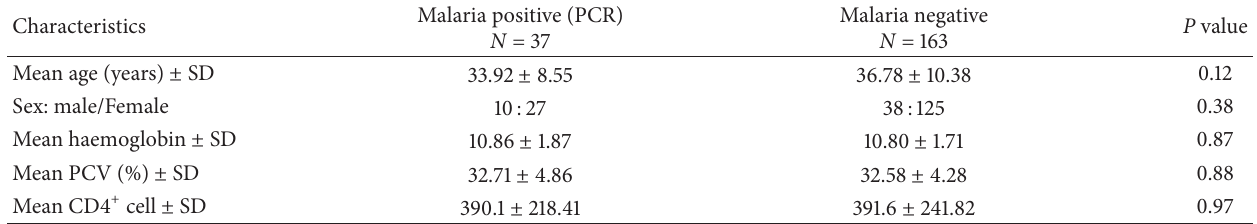
Table 2: Comparison between malaria positive and negative HIV patients attending IHVN Clinic recruited into the study. Characteristics